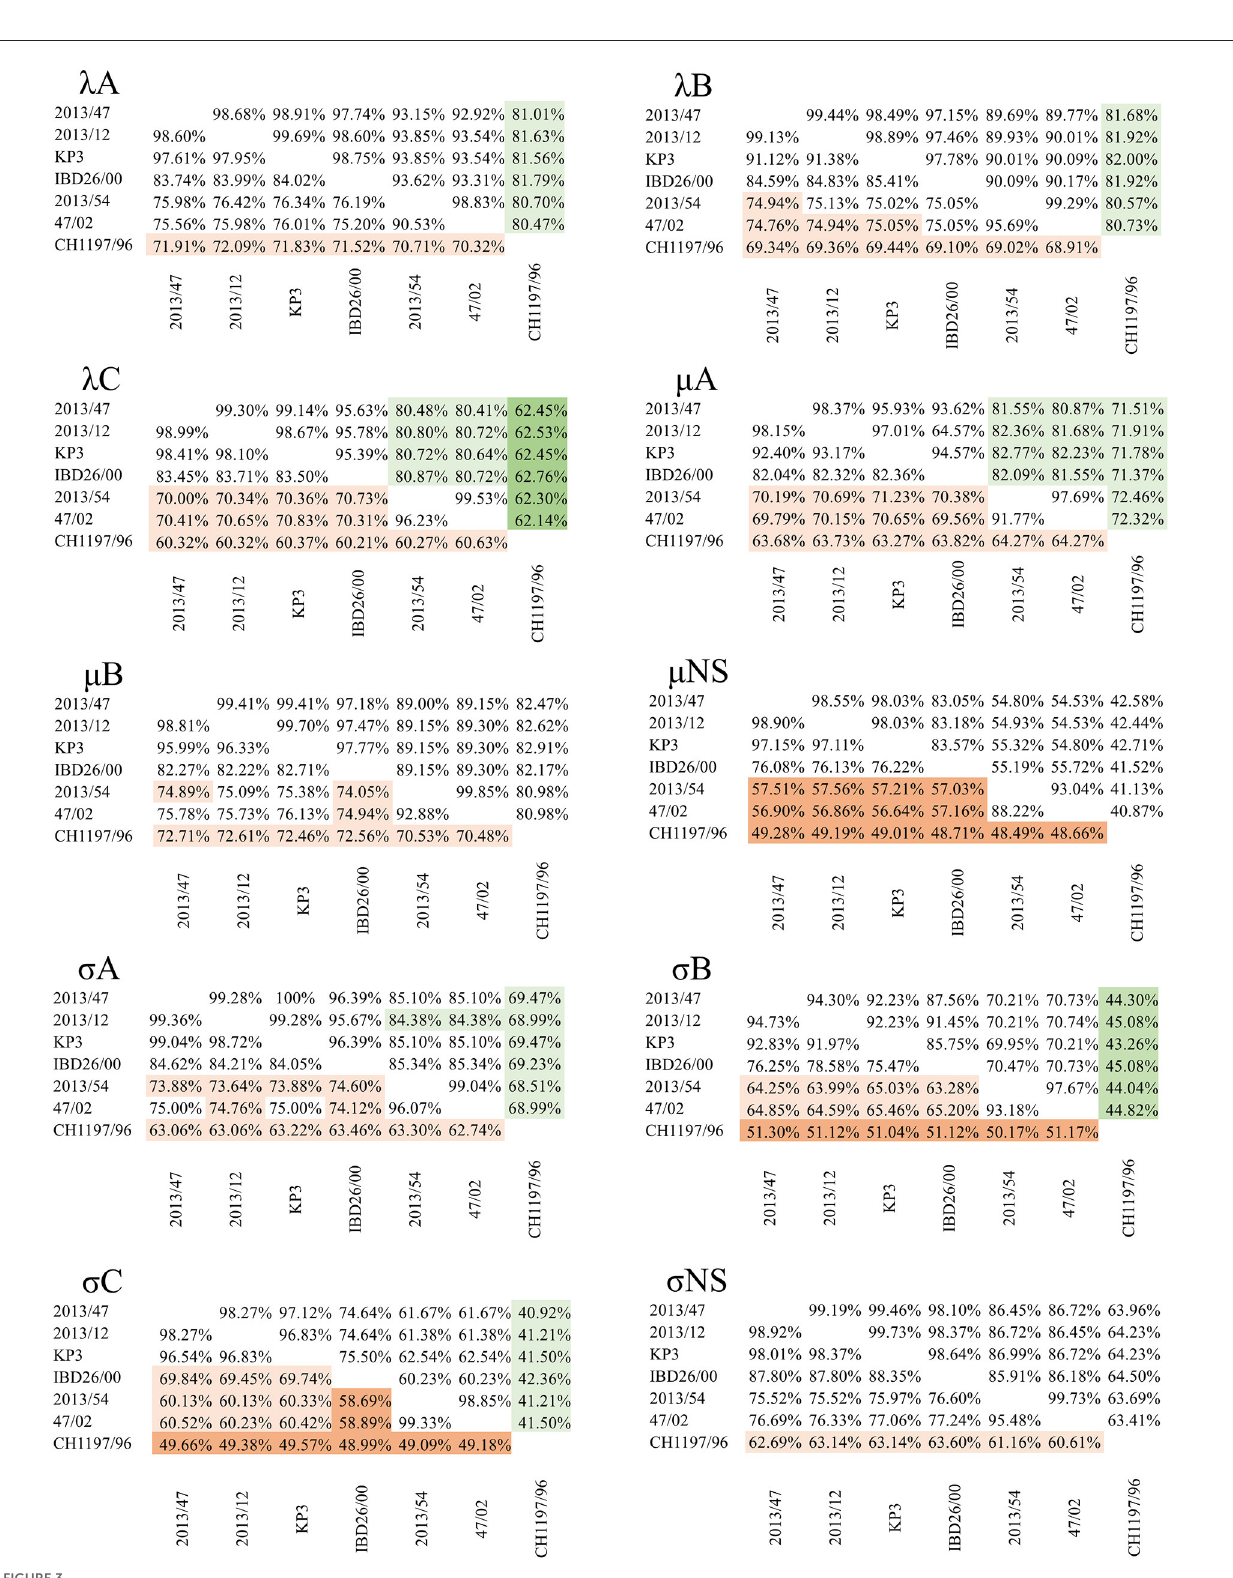
FIGURE3 Pairwise identity values of nucleotide (lower left triangle) and amino acid (upper right triangle) sequences of the corresponding genes from reptilian origin orthoreoviruses. Values under the demarcation criteria for different species are indicated by dark orange (nt) and dark green (aa); values between the two cut-off values (i.e., above the cut-off value for different but under the value for identical species) are indicated by light orange (nt) and light green (aa)